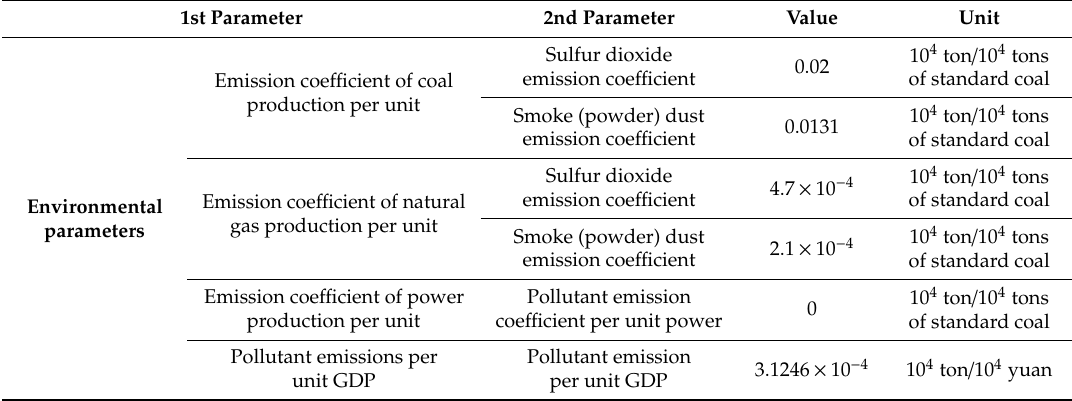
Table 3. Environment parameters of a water–energy–food system in Inner Mongolia.